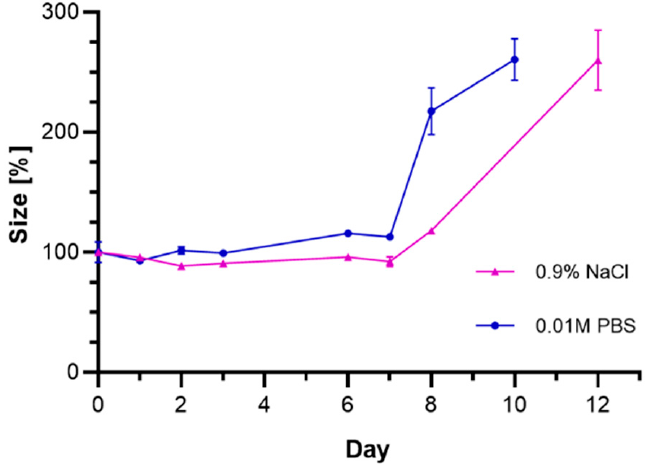
Table 2. Hydrodynamic size and zeta potential of synthesized bioconjugate.